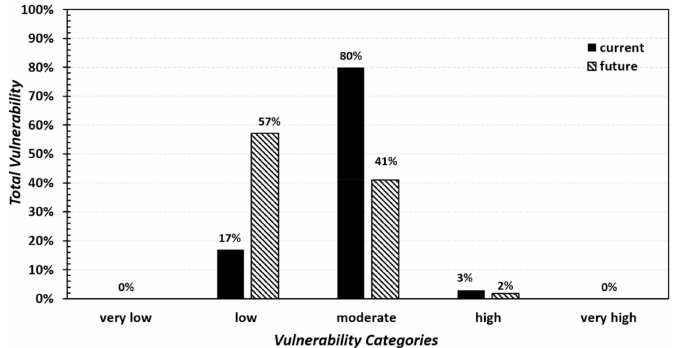
Figure 11. Current and future total vulnerability in Hurghada.